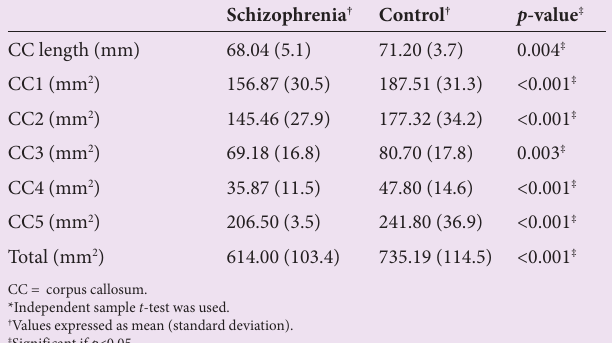
Table 2. Midsagittal CC length and area measurements of all schizophrenia patients compared with control